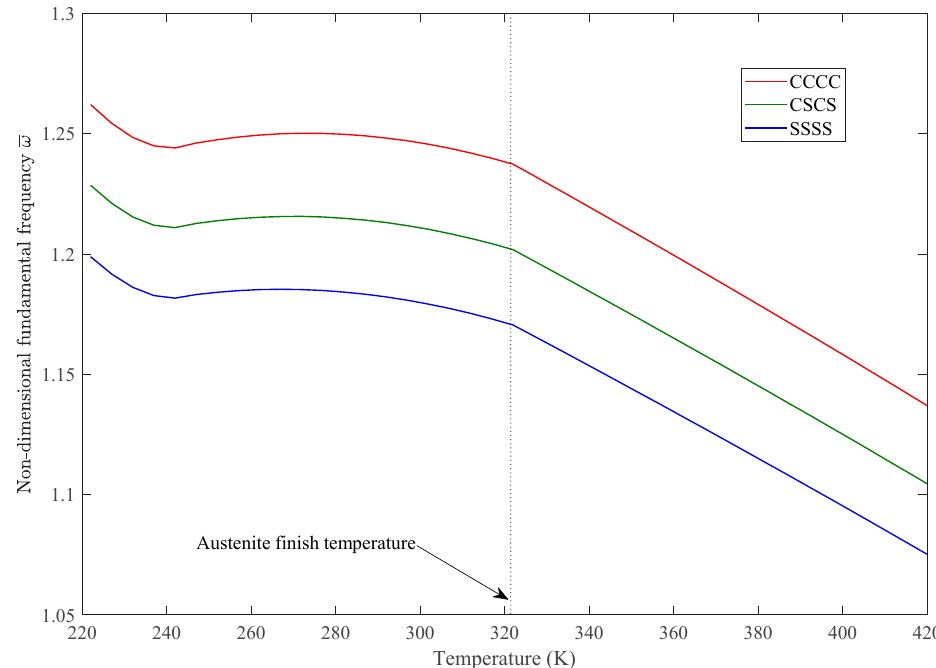
Figure 8. Variation of nondimensional fundamental frequency with temperature for different boundary conditions, with [SMAHC/0/0/0]s, Vs = 15%, ε = 5%.